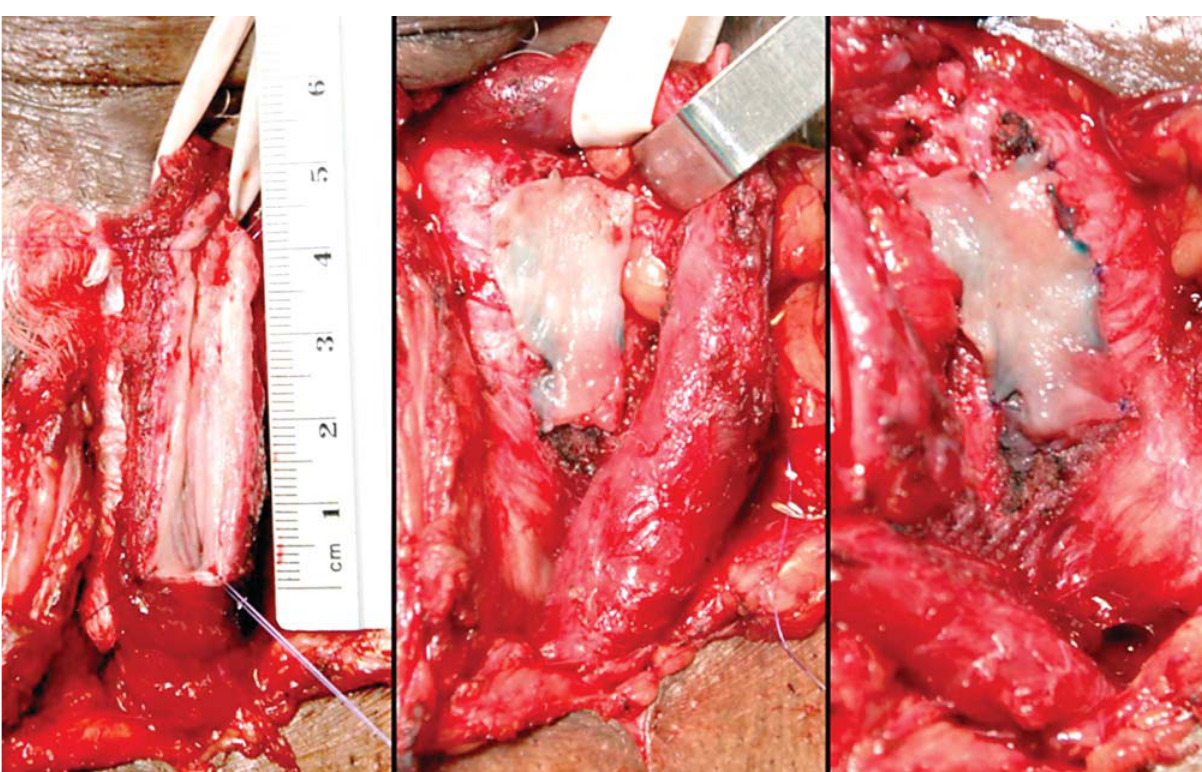
Figure 4 – The tunica vaginalis graft was placed dorsally over the corpora cavernosa and tied with 6 running polydioxanone 6-0 sutures.